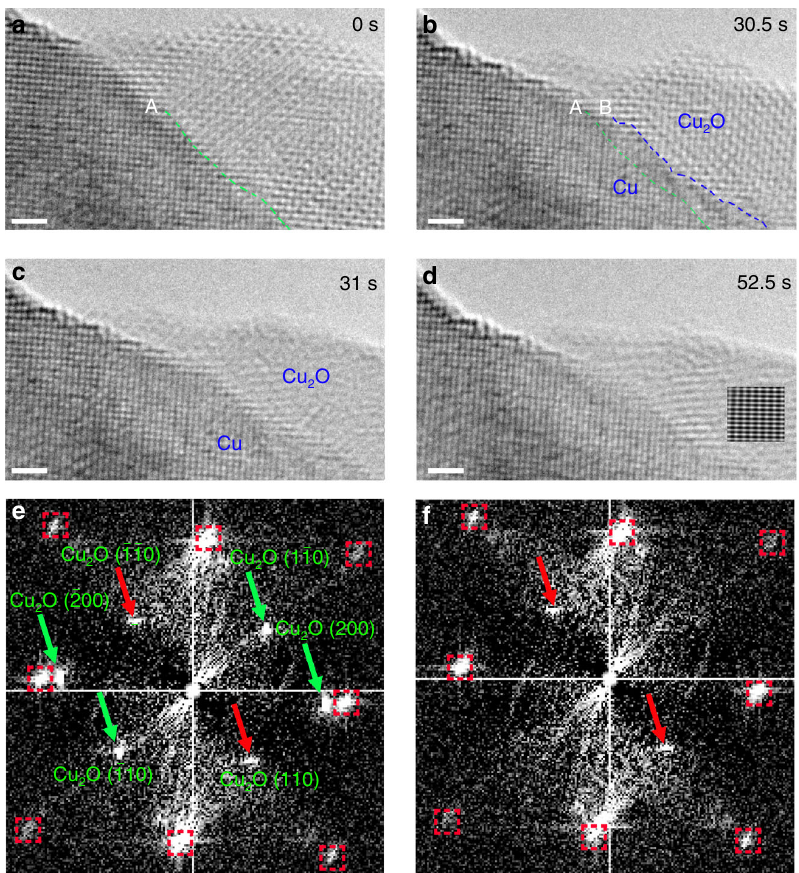
Fig. 3 Cu 2 O island rotation along the Cu 2 O/Cu interface. a – d Time-sequence HRTEM images of the Cu 2 O → Cu reduction at T = 350 °C and p H 2 = 4 × 10 − 2 Torr (Supplementary Movie 3). Dashed lines A and B mark the locations of the Cu 2 O/Cu interface at 0 s and 30.5 s, respectively. The inset in d is a simulated HRTEM of the Cu 2 O grain tilted by 33° with respect to the < 001 > direction. e , f Diffractograms of HRTEM images b and c , green and red arrows mark the Cu 2 O diffraction spots that disappear and remain, respectively, due to the rotation of the Cu 2 O island; the red dashed squares mark the Cu diffraction spots, which remain unchanged during the time interval. Scale bar , 1